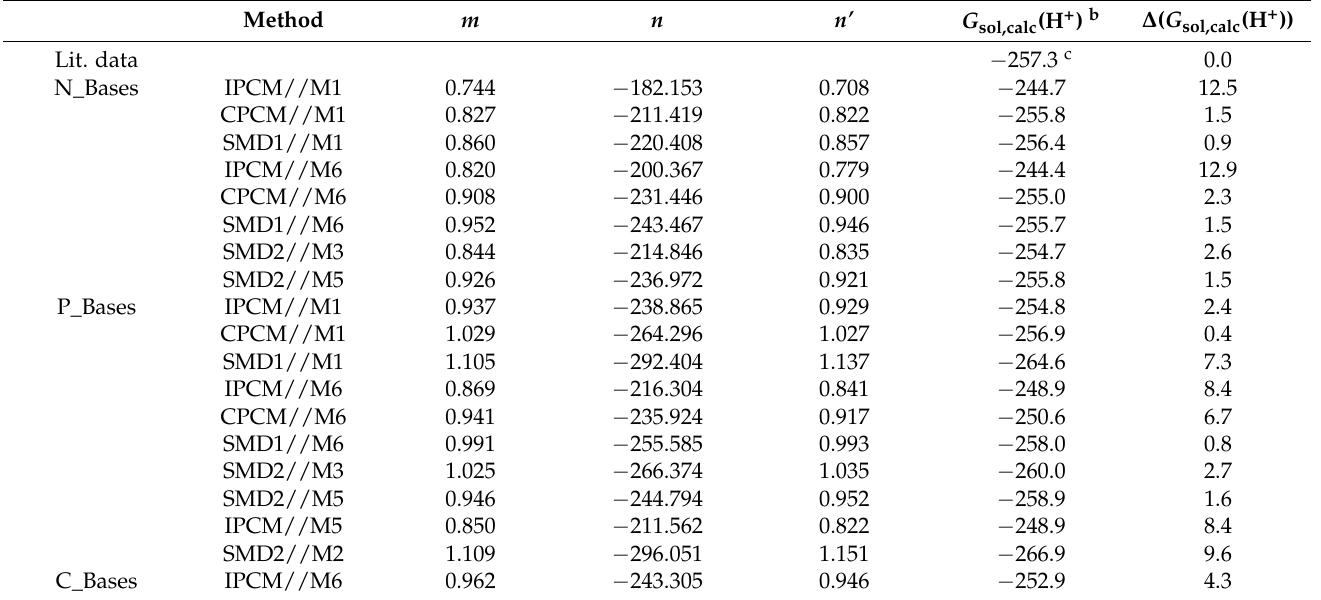
Table 3. Parameters m and n derived from the correlations used to estimate G sol,calc (H + ) a